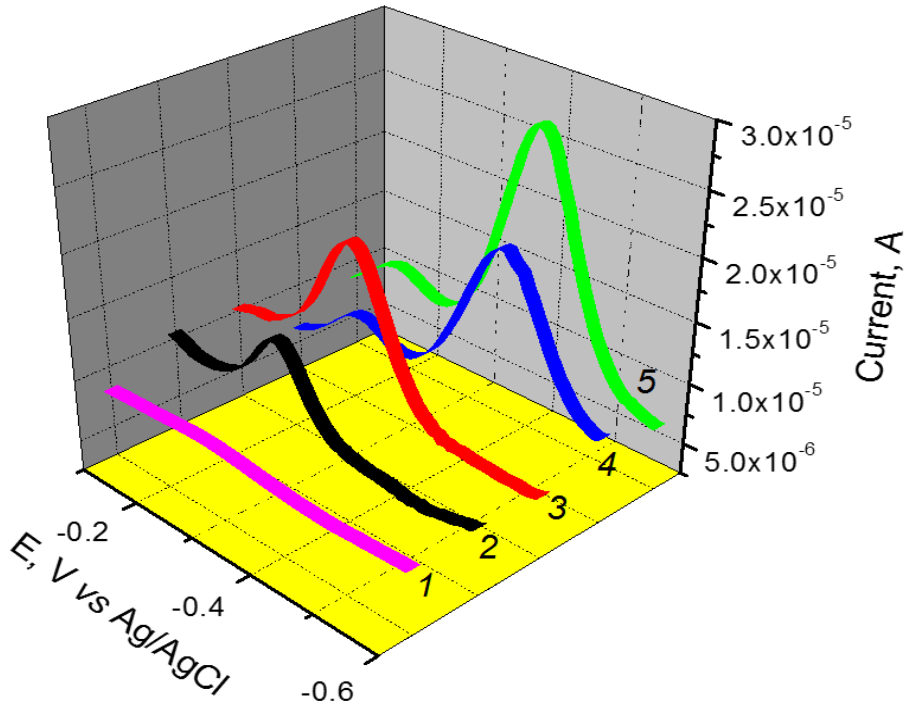
Figure 3. Differential pulse voltammetry (DPV) curves recorded in 0.1 M PBS (pH 5.5) containing 1 µM of NBA on (2) bare GCE, (3) GCE/HA, (4) GCE/Lys, and (5) GCE/Lys/HA. (1) represents the curve recorded in blank electrolyte using GCE/Lys/HA.